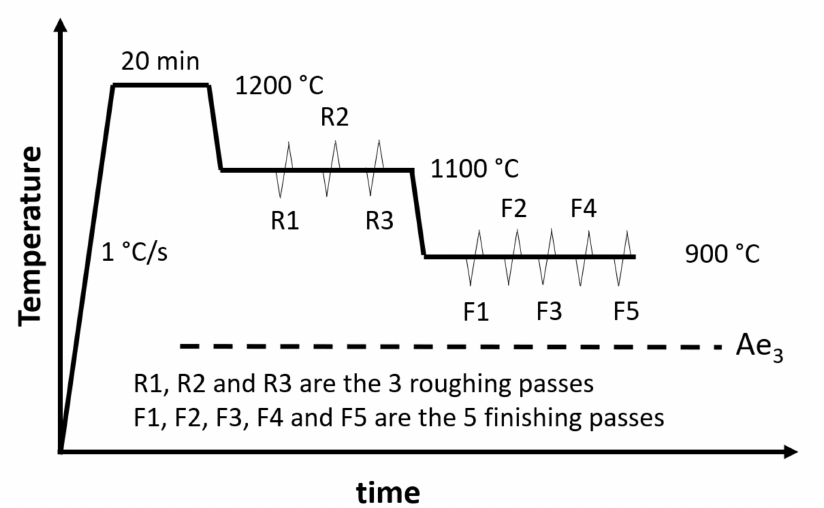
Figure 1. Thermomechanical schedule for the plate rolling simulations by means of torsion testing. The deformation temperature for the roughing and finishing passes were 1100 ◦ C and 900 ◦ C,